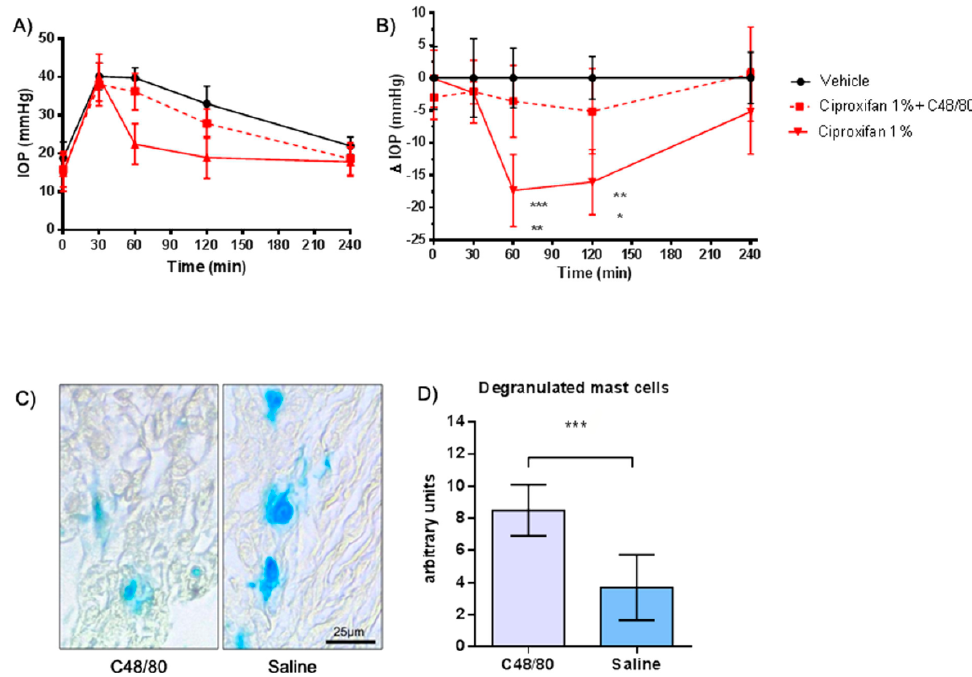
Figure 4. ( A , B ) C48/80 intraocular pressure (IOP) time course. *** p < 0.001 ciproxifan 1% at 60 ′ versus vehicle; ** p < 0.01 ciproxifan 1% at 60 ′ versus ciproxifan + C48/80, ciproxifan 1% versus vehicle at 120 ′ ; * p < 0.05 ciproxifan 1% at 60 ′ versus ciproxifan + C48/80. Data are expressed as mean ± SEM ( n = 5). Two-way ANOVA followed by Bonferroni post hoc test.; ( C ) Blue Astra staining of mast cells in the choroid; ( D ) *** p < 0.001 C48/80 treated eyes versus saline-treated eyes with Welch’s correction t -test. Compounds were instilled in drops into the lower conjunctival pocket.